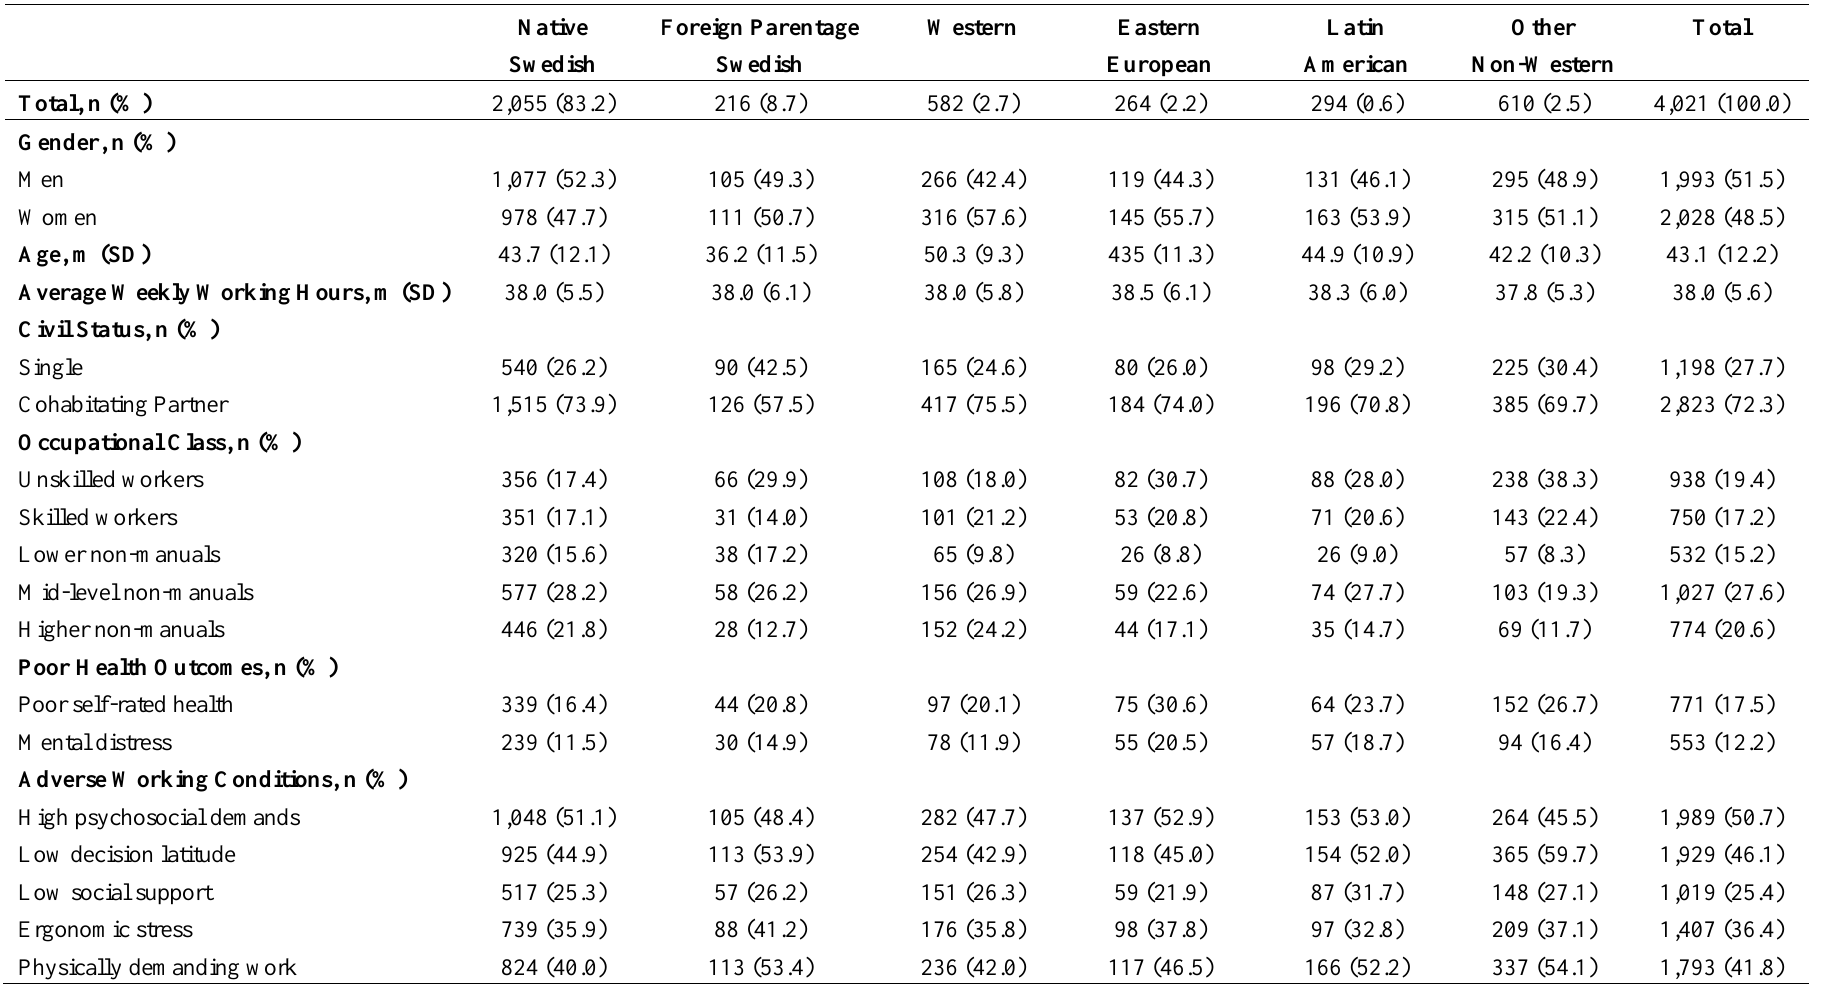
Table 1. Background variables and prevalence of adverse working conditions and poor health outcomes by region of origin *.